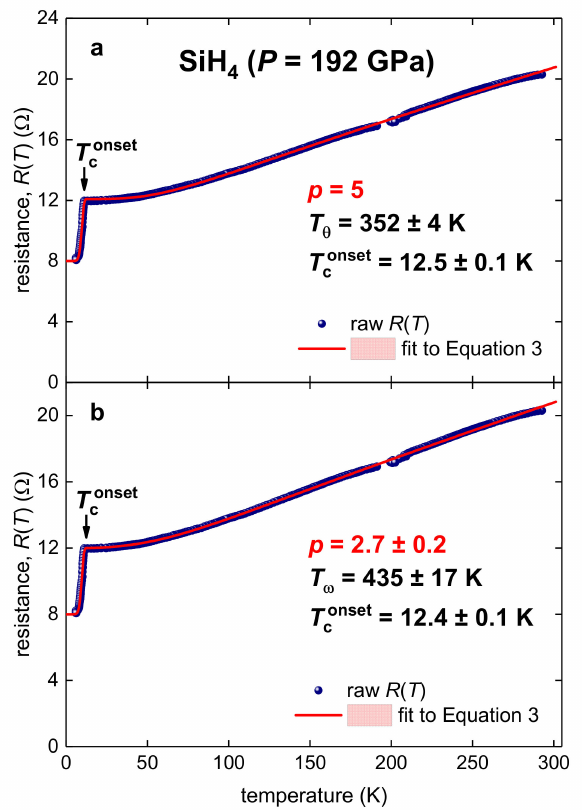
Figure 4. R ( T ) data and fits to Equation 3 for highly compressed silane ( P = 192 GPa) (experimental data digitized from Figure 2b in Reference [12]). ( a )— p = 5, T θ = 352 ± 4 K, T onset c = 12.5 ± 0.1 K, fit quality is 0.9995; ( b )—deduced p = 2.7 ± 0.2, T ω = 435 ± 17 K, T onset c = 12.4 ± 0.1 K, fit quality is 0.9996. The fitting curves are red; confidence bands at 95% are shown by a pink shaded